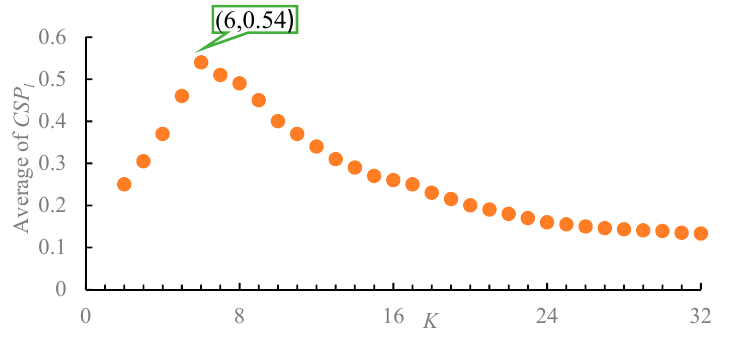
CSP Figure 6. The average value of CSP l with the different number of Figure 6. The average value of l with the different number of zones.